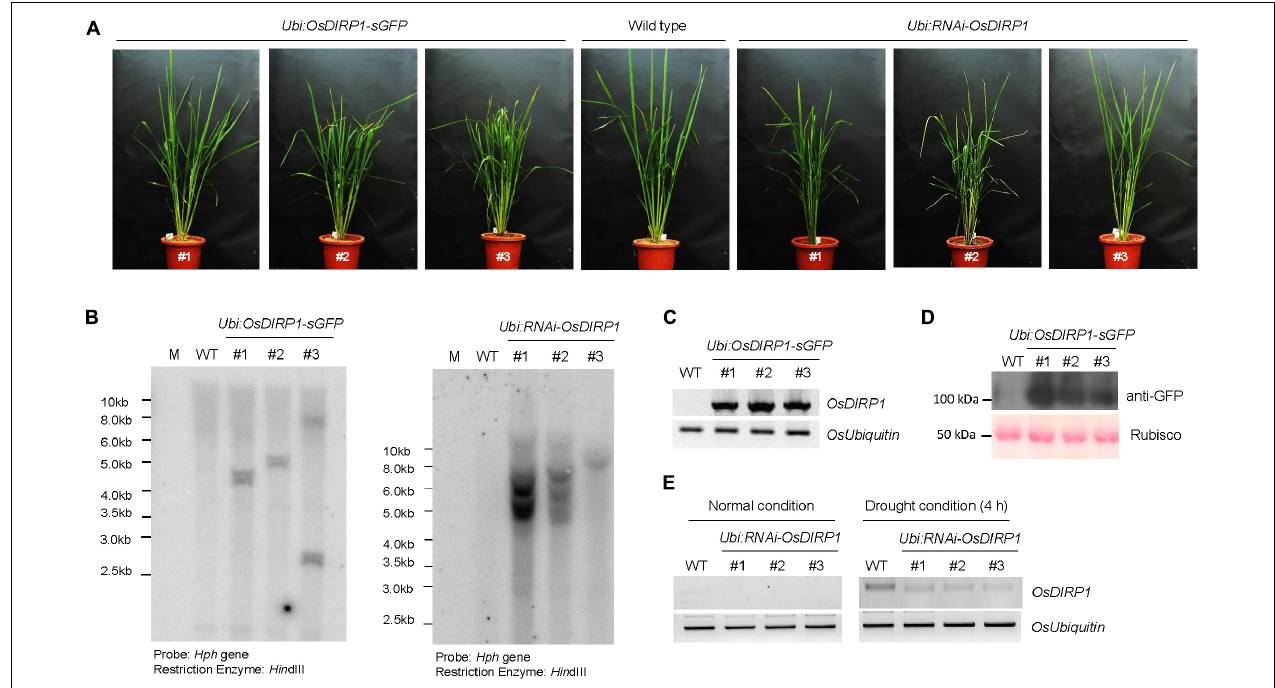
FIGURE 2 | Molecular characterization of OsDIRP1- overexpressing and RNAi -mediated knock-down transgenic rice plants. (A) Morphology of 2-month-old wild-type (WT), T4 Ubi:OsDIRP1-sGFP , and T4 Ubi:RNAi-OsDIRP1 rice plants grown under long-day conditions (16 h light and 8 h dark). (B) Genomic Southern blot analysis. Total leaf genomic DNA was isolated from wild-type (WT), T4 Ubi:OsDIRP1-sGFP (lines #1, #2, and #3), and T4 Ubi:RNAi-OsDIRP1 (lines #1, #2, and #3) rice plants. The DNA was digested with Hin dIII and hybridized to a 32 P-labeled hygromycin B phosphotransferase ( Hph ) probe under high stringency conditions. (C) RT-PCR analysis of the wild-type (WT) and T4 Ubi:OsDIRP1-sGFP (independent lines #1, #2, and #3) transgenic rice plants to examine OsDIRP1 transcript levels. OsUbiquitin was used as a loading control. (D) Immunoblot analysis of wild-type (WT) and T4 Ubi:OsDIRP1-sGFP plants. Total proteins were isolated using 2x SDS sample buffer and immunoblotted with anti-GFP antibody. Rubisco was used as an equal loading control. (E) RT-PCR analysis of the wild-type (WT) and T4 Ubi:RNAi-OsDIRP1 plants. RNA was isolated from whole seedlings of non-drought-treated (0 h) and drought-treated (4 h) wild-type (WT) and Ubi:RNAi-OsDIRP1 (lines #1, #2, and #3) plants. OsUbiquitin was used as a loading control. TABLE 1 | Agronomic traits of the wild-type (WT), T4 Ubi:OsDIRP1-sGFP (OE, independent lines #1, #2, and #3), and T4 Ubi:RNAi-OsDIRP1 (KD, independent lines #1, #2, and #3) rice plants grown in the paddy field conditions. Agronomic